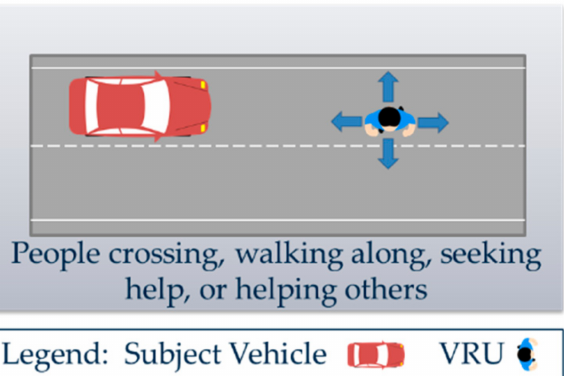
Figure 3. A single and non-obstructed pedestrian is standing on, crossing, or walking along the highway. People can also be seeking help, helping others, or trying to collect a fallen item on the